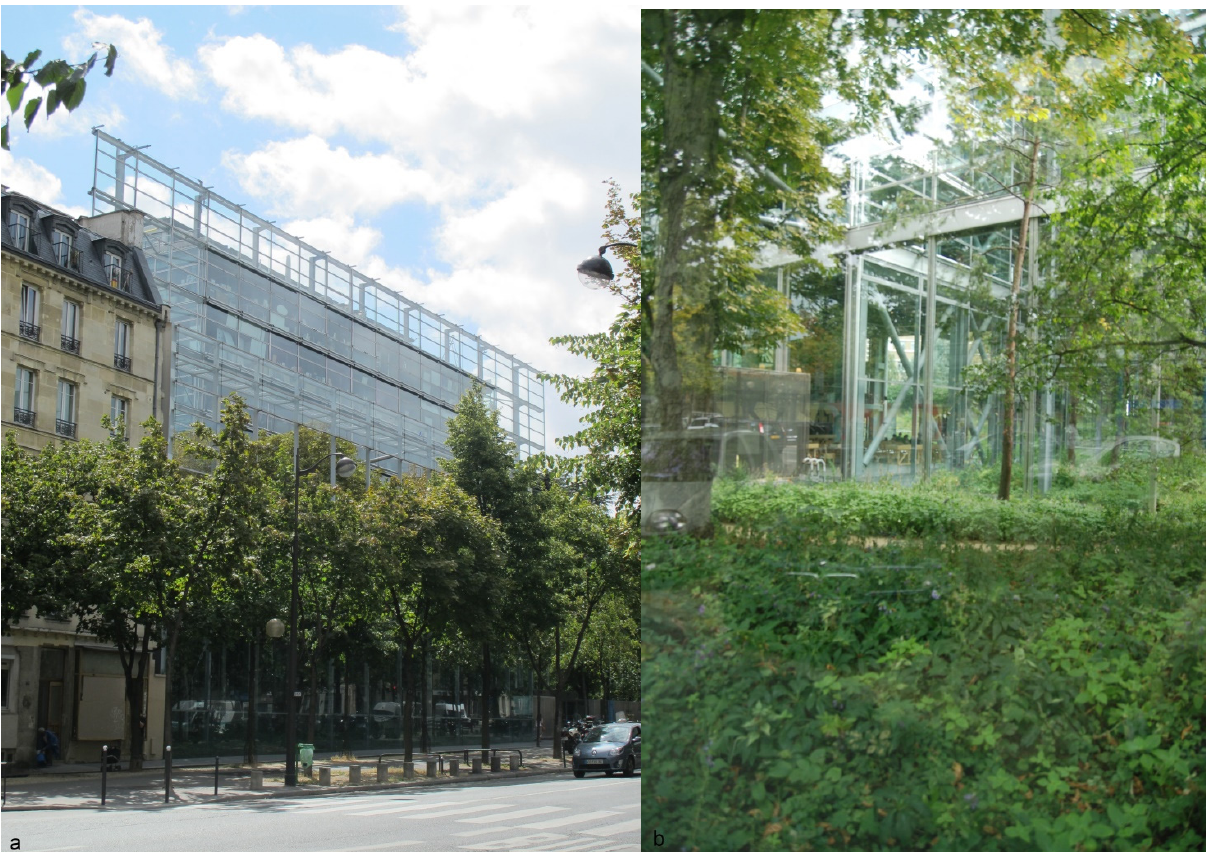
Figure 8. ( a ) Façade of the Cartier Foundation building in Paris; ( b ) close-up showing the super- imposition of plans through the transparency and reflexivity of glass. Photo: Anna Jó ź wik, Paris in 2011.